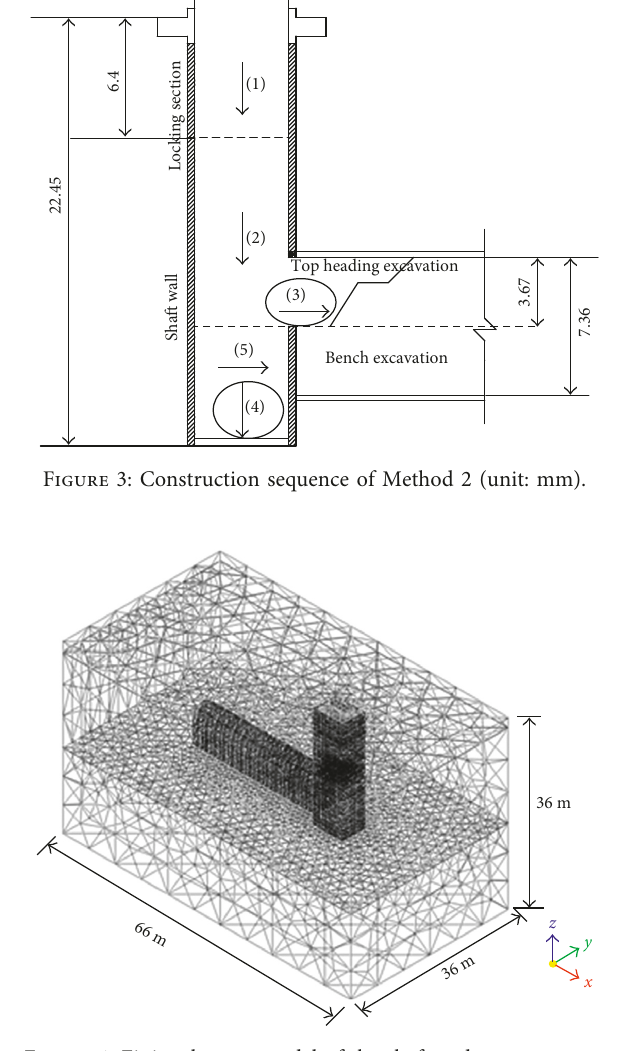
Figure 4: Finite element model of the shaft and cross